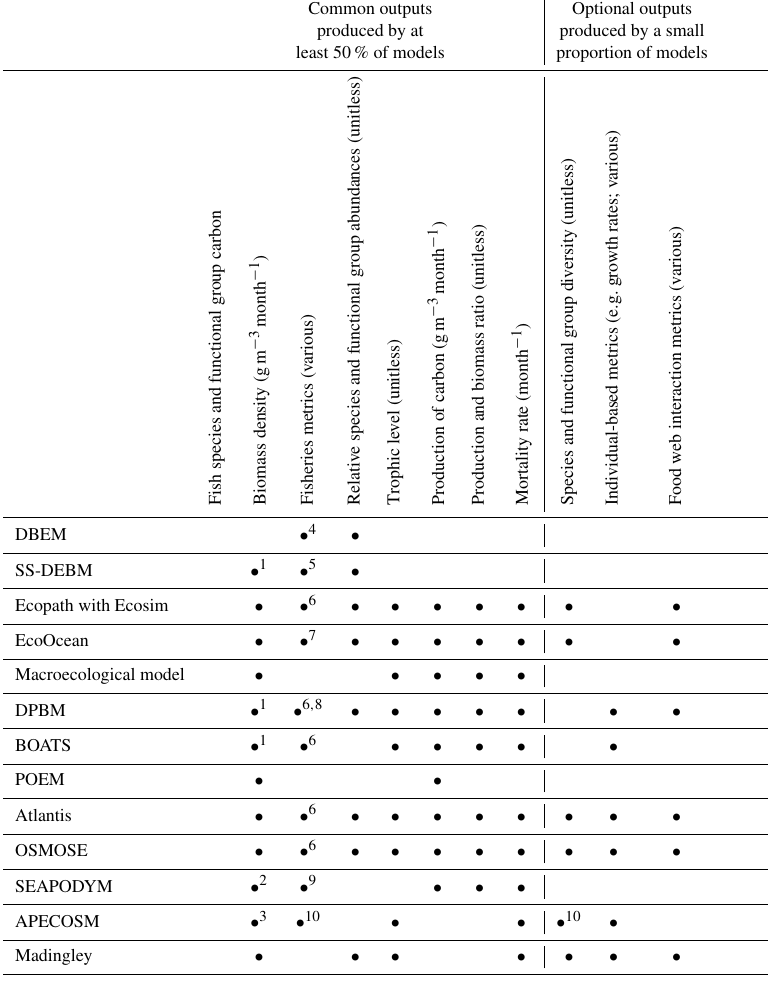
Table 4. Selected outputs produced by individual models. Note that this list is correct at the time of printing, but that models are continuously in development with new components and requirements being added. This table lists a range of potential outputs from models participating in Fish-MIP; for the list of requested and optional model outputs, see Table